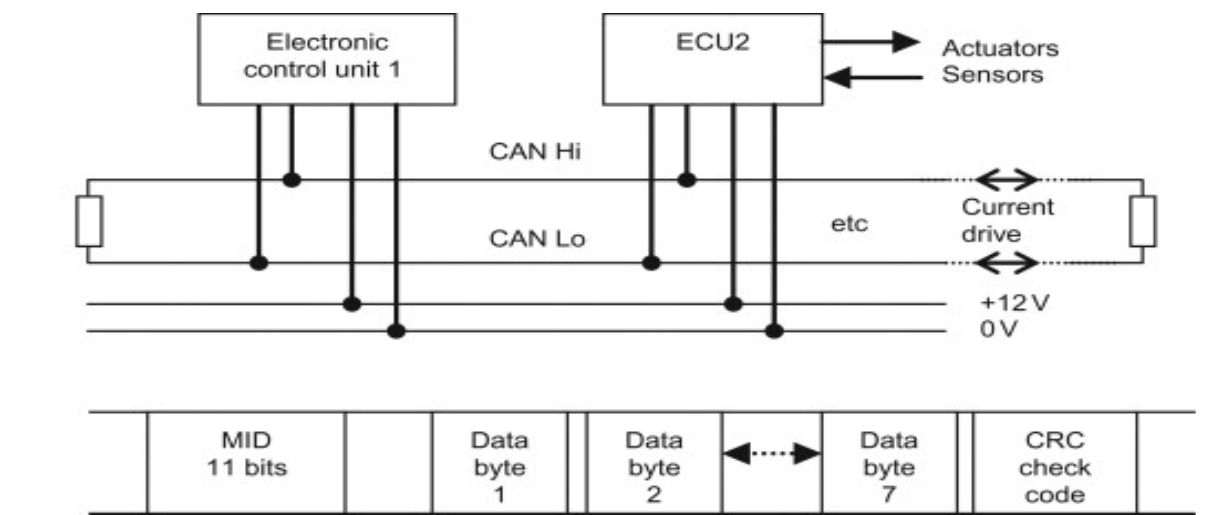
Figure 2. A CAN bus: ( a ) system connections and ( b ) frame format.